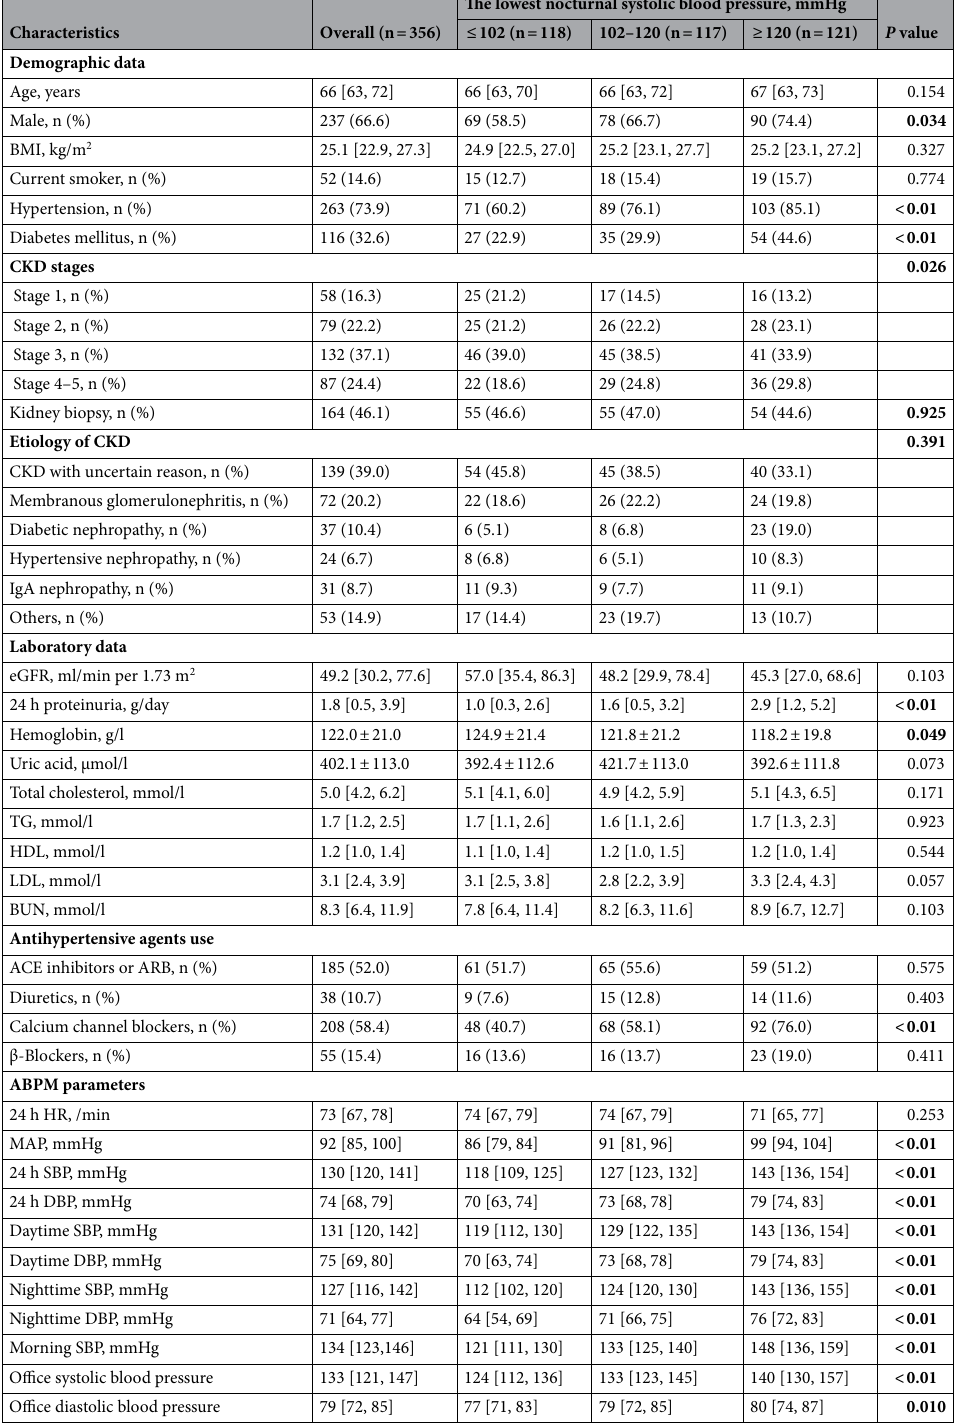
Table 1. Baseline characteristics of patients according to tertiles of the lowest nocturnal systolic blood pressure. Mean ± (SD) for normal distribution variables, median (interquartile range) for non-normal